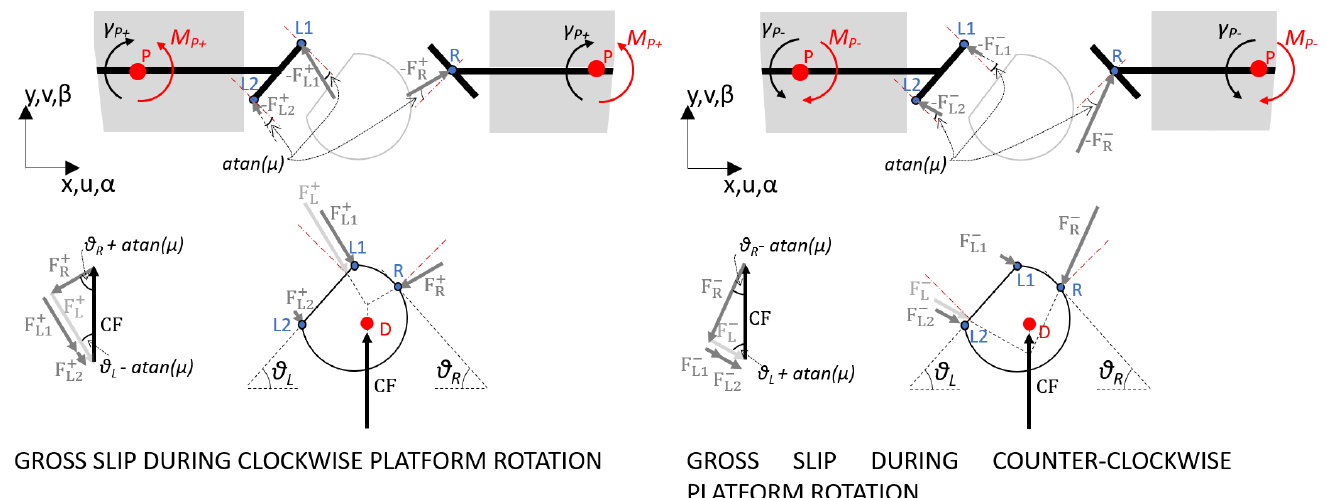
Figure 8. Detail of forces on a damper (bottom row) and corresponding forces and their moments on the two adjacent platforms in contact with that damper for an In-Phase mode of vibration.